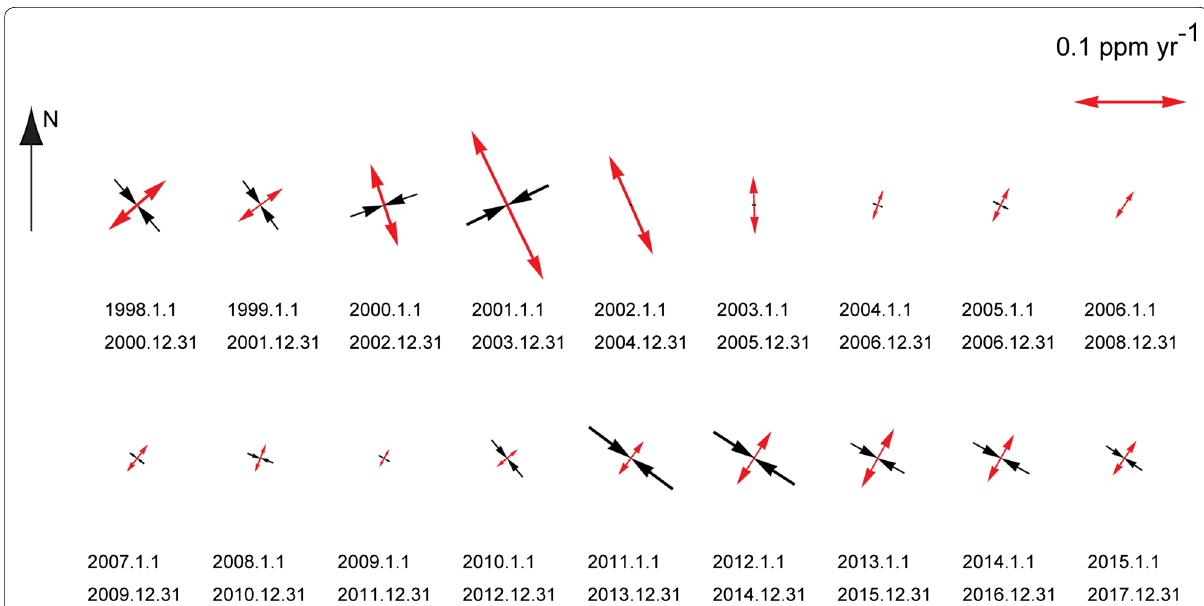
Fig. 6 Averaged principal strain axis for every 3 years in the Yaeyama Islands from 1999 to 2016. Red arrows and black arrows show the extensional and compressional axis,